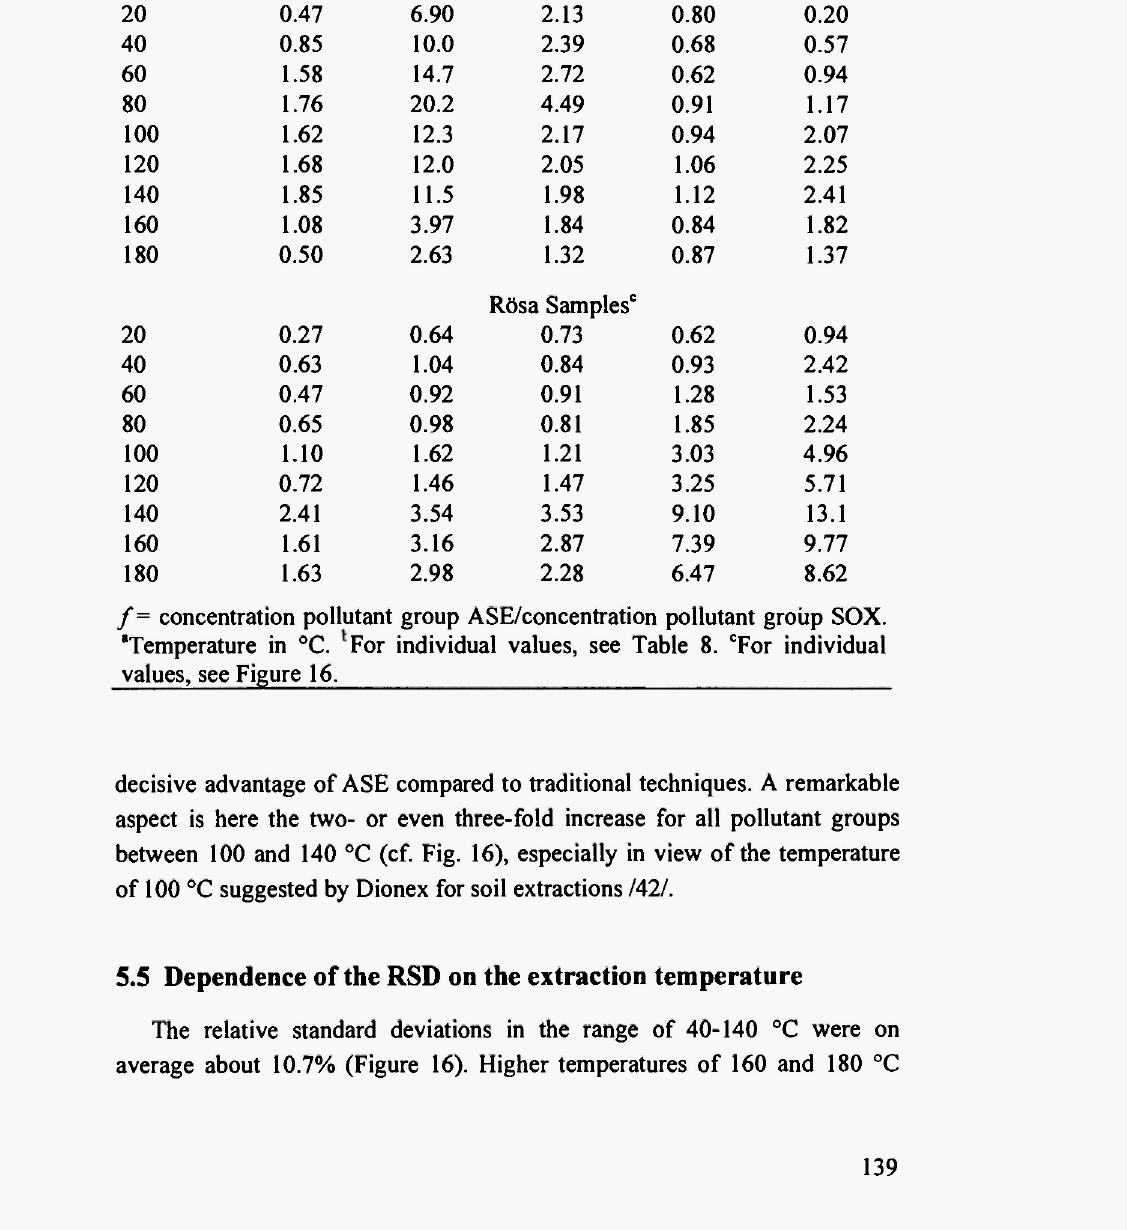
Ratio Factors/for the Extraction Efficiencies of ASE vs